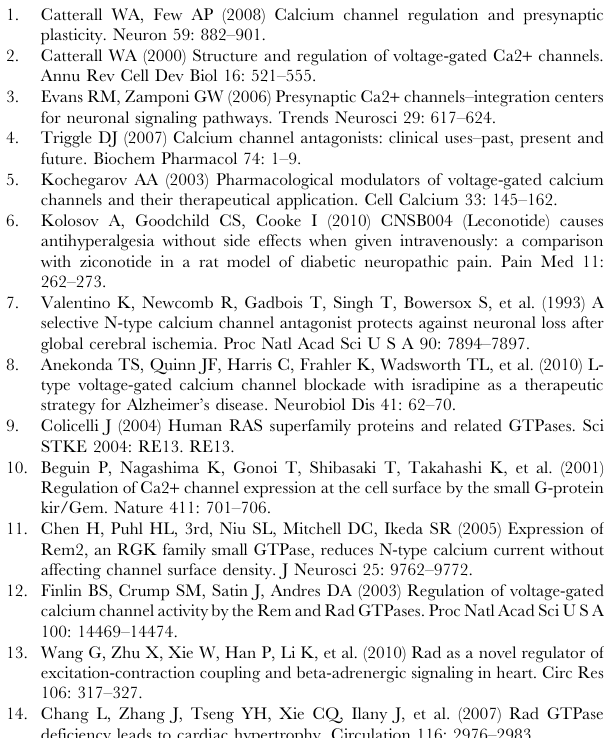
Figure S6 Lack of interaction of Gem, Rem2, and Rad with a 1C N-terminus. (A) Confocal images of YFP- a 1C NT with CFP-tagged Gem, Rem2, and Rad show little co-localization. Scale bar, 5 m m. (B) Relative membrane to cytosol fluorescence intensity ratios for YFP- a 1C NT co-expressed with distinct CFP- tagged RGK proteins. (C) Co-immuoprecipitation assay to probe for a 1C NT interaction with Gem, Rem2, or Rad provides no evidence of an association. Figure S7 Lack of interaction of Rad with a 1C intracel- lular loops. (A) Confocal images of mCherry-Rad and CFP- tagged a 1C intracellular loops and termini show no evidence of co- localization. Scale bar, 5 m m. (B) Relative membrane to cytosol fluorescence intensity ratios for YFP-tagged a 1C intracellular loops co-expressed with distinct mCherry-tagged Rad. (C) Co-immuno- precipitation assays indicate no interaction between Rad and the major a 1C intracellular loops.